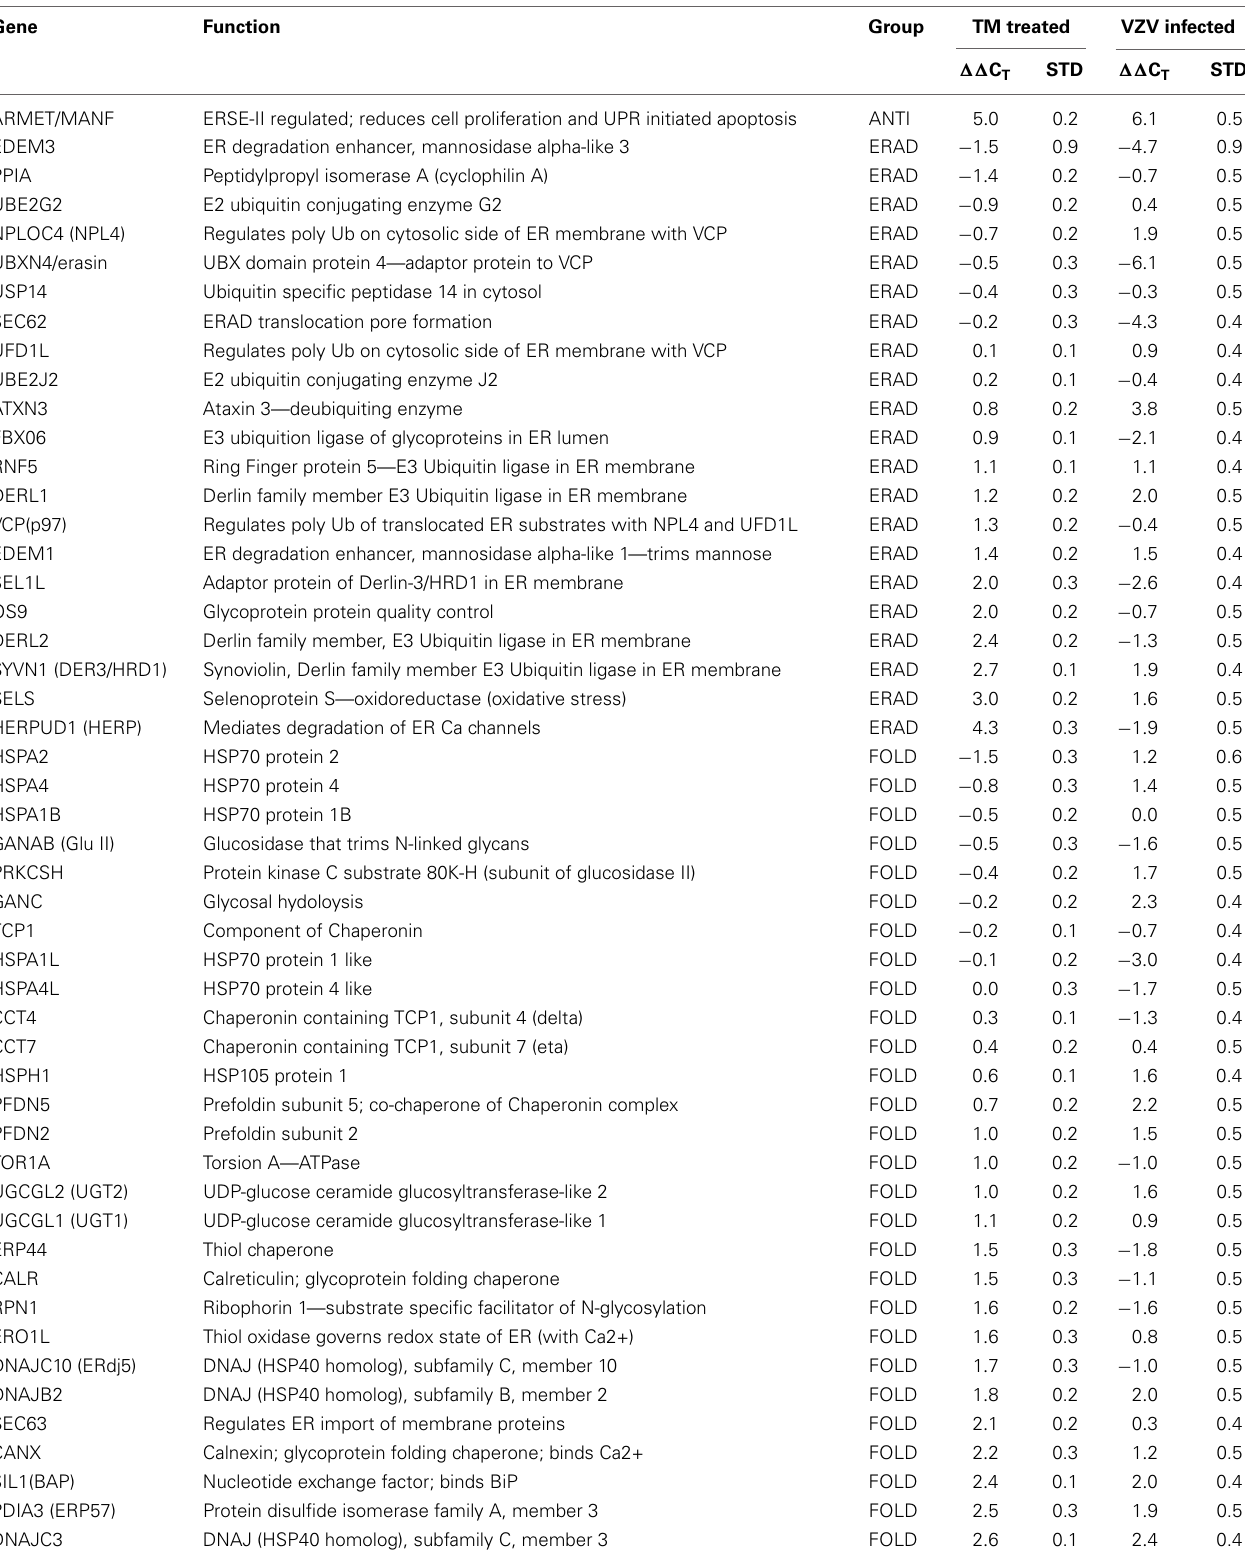
Table 1 | UPR qPCR results for tunicamycin treated and VZV infected cells.